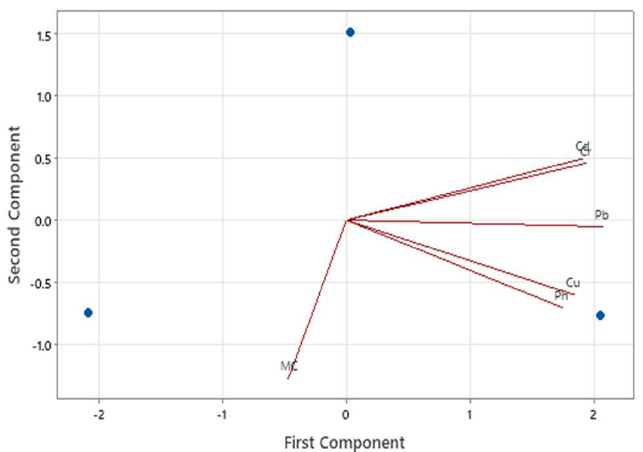
Figure 4. Principal component analysis plots showing the effect of two components influencing the variation of HMs in sediments from Port Bell, L. Victoria, Uganda.